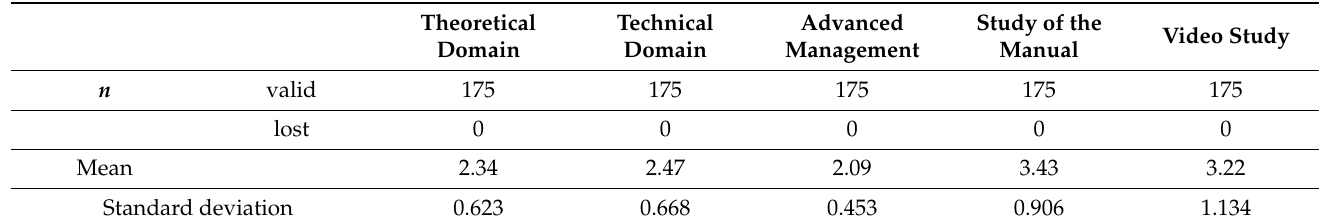
Table 3. Perception of knowledge/learning of students (according to the students themselves).